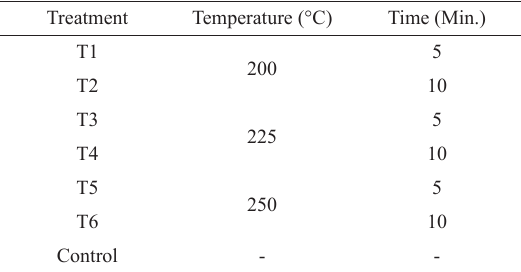
Table 1: Type of heat treatment.